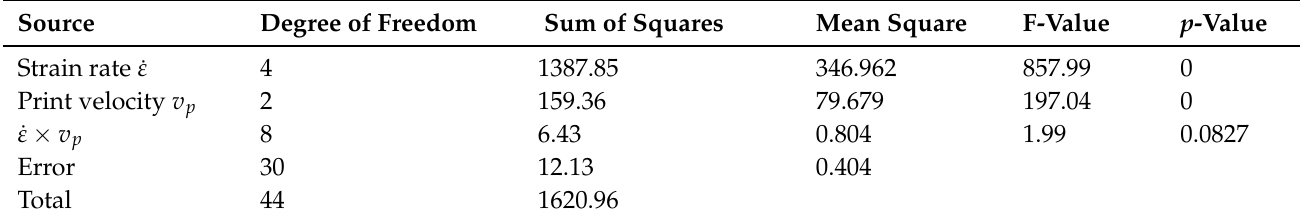
Table 4. Analysis of Variance (ANOVA) results of an interaction model for the engineering yield stress versus logarithmic strain rate and print